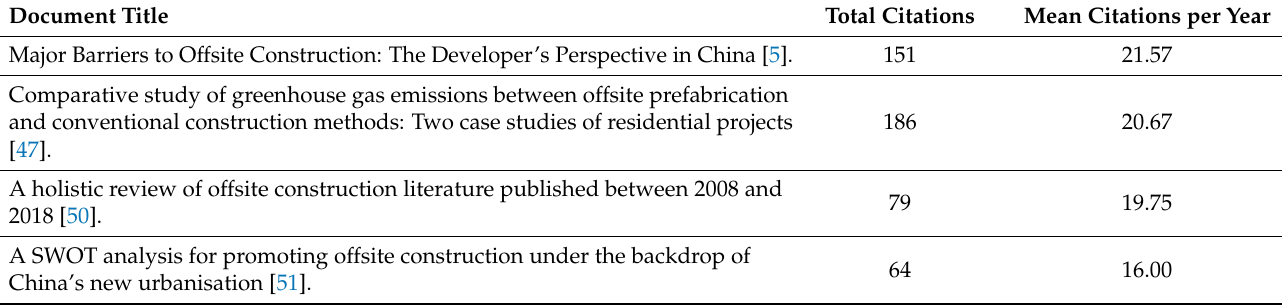
Table 2. Most frequently cited papers on